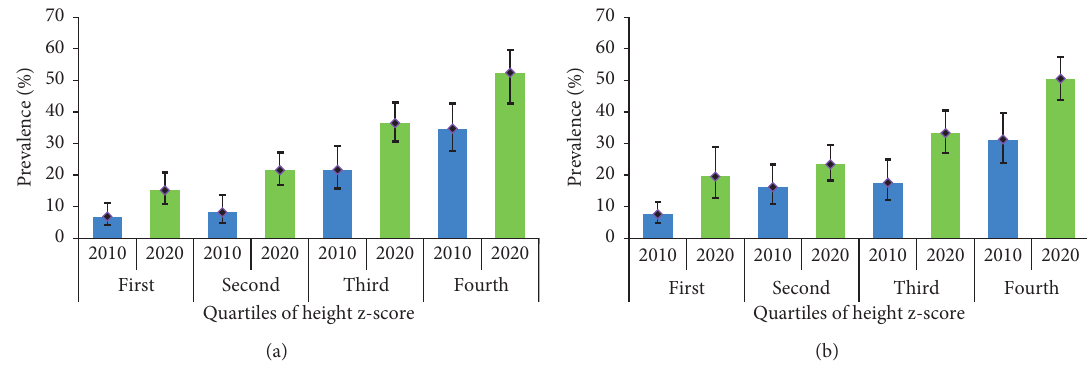
Figure 3: Adjusted prevalence (%, 95% CI) of BMI overweight/obesity across quartiles of height z-score in males (a) and females (b).